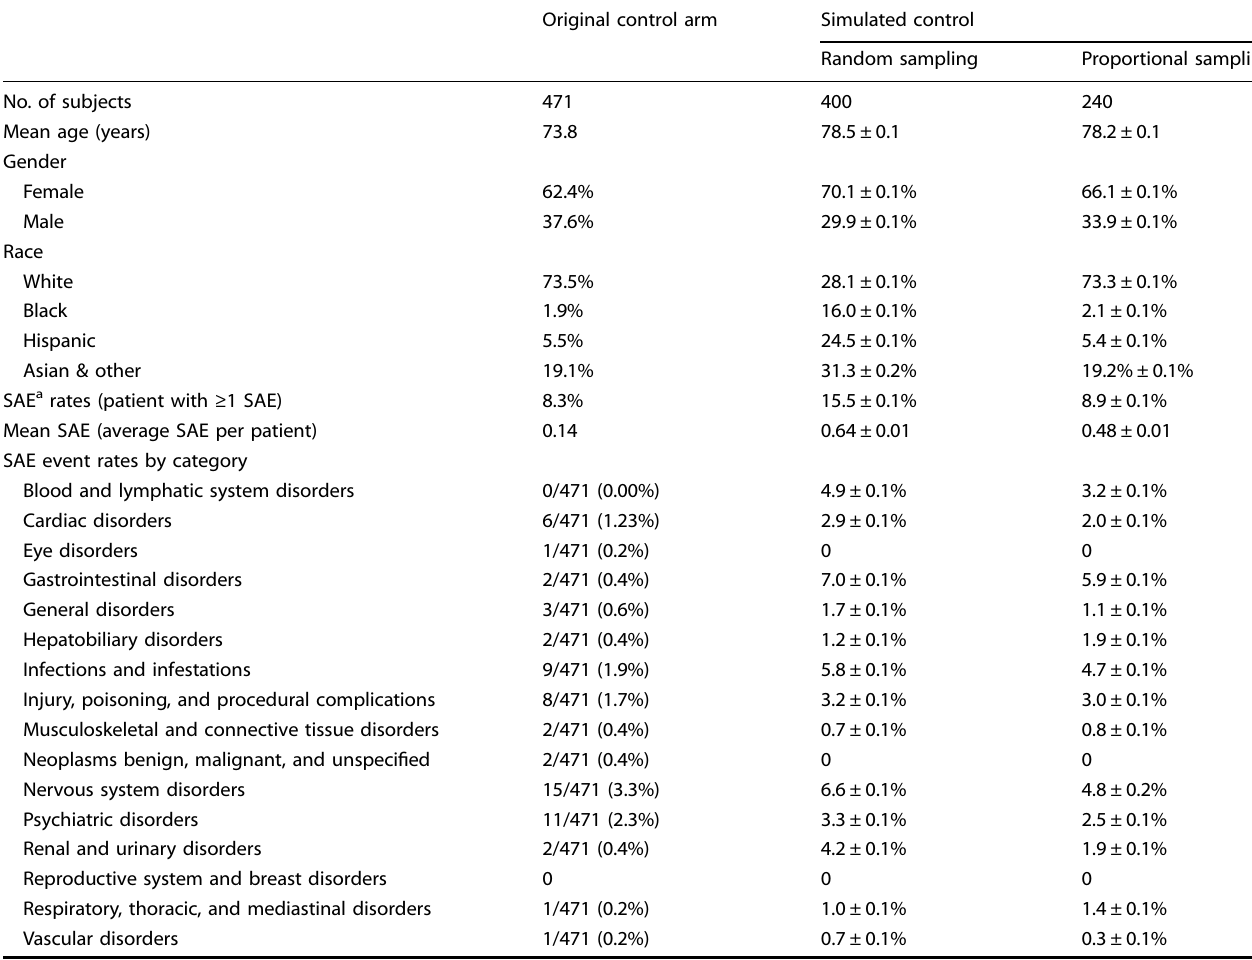
Table 2. One-arm simulation results for the 10 mg control